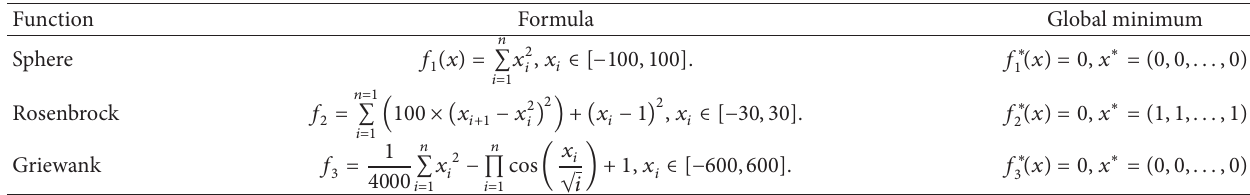
Table 1: Benchmark functions.